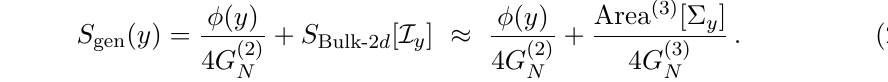
Figure 3 . (a) We have shown, from the 2d perspective, the two contributions (cid:30) ( y ) to S gen ( y ) from equation (2.10). (b) Since the matter CFT 2 is holographic, the quantity S Bulk-2 d [ I y ] can be computed using a 3d RT